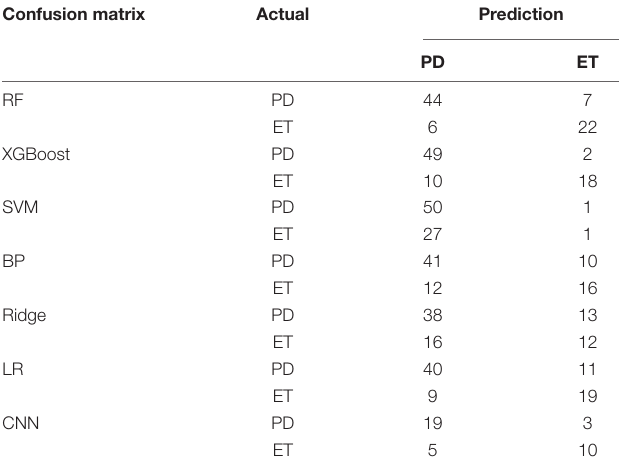
TABLE 3 | Confusion matrices of seven models.